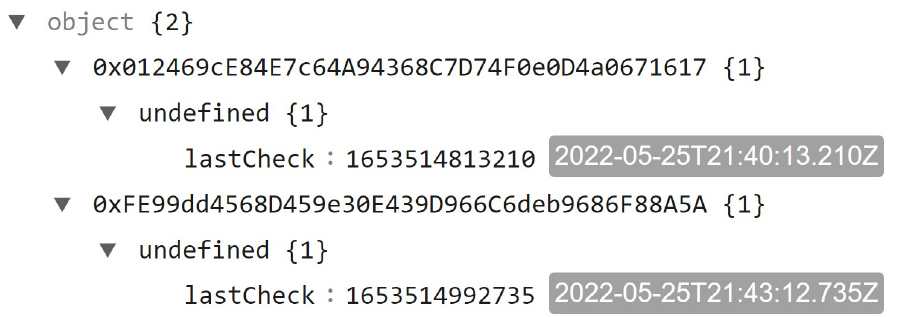
Figure 22. The value recovered from the row (i.e., @MetaMask:lastIncomingTxBlockInfo) that contains the user-connected wallets addresses and last time they were